Question: Describe this figure in one sentence.
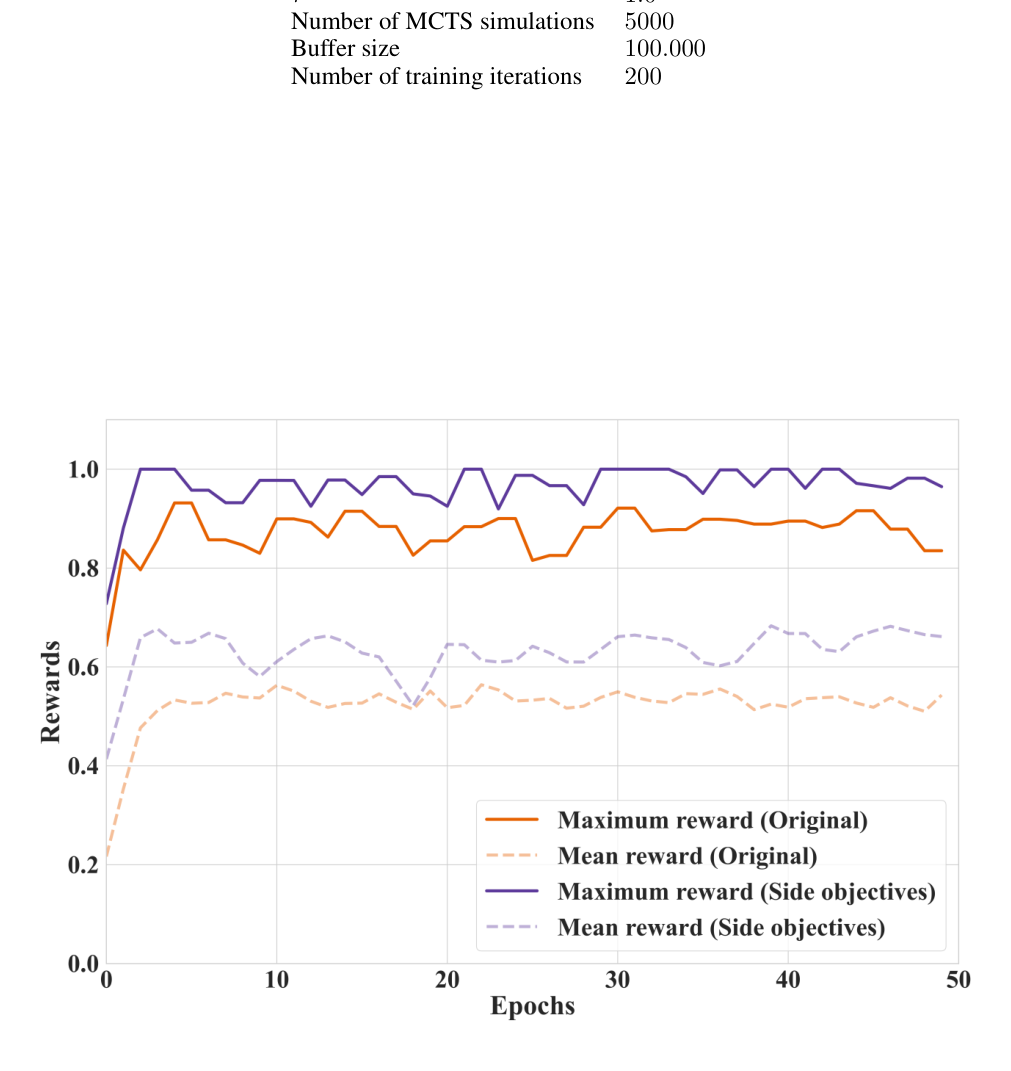
Answer: Rewards of the AlphaZero agents throughout training. Both AlphaZero (side-objectives) maximum and mean rewards are consistently higher than those of AlphaZero (original).